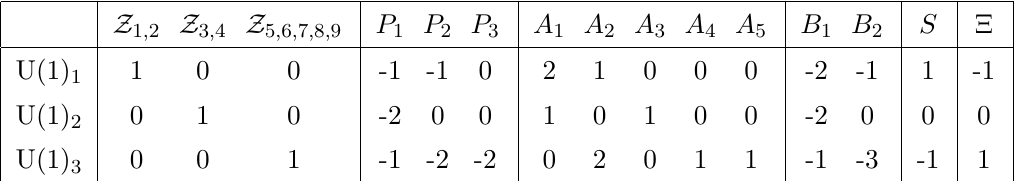
Table 3 . GLSM charges of the monad bundle on CICY